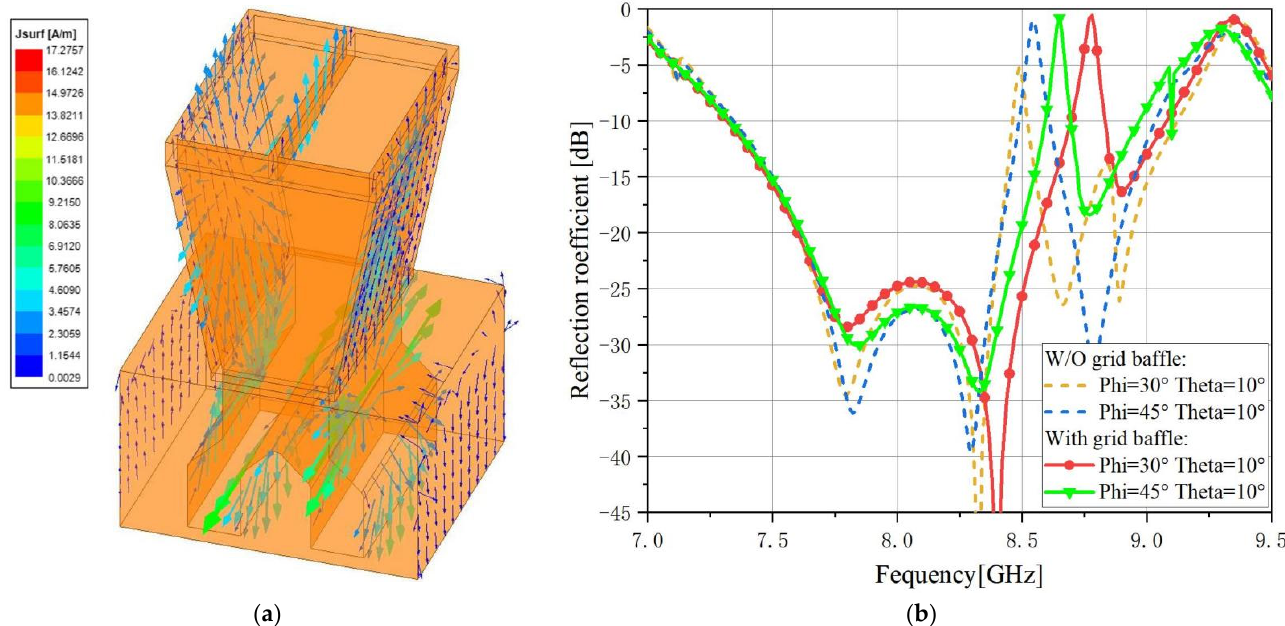
Figure 4. ( a ) The surface current distribution at the horn aperture with the grid baffle added. ( b ) The active reflection coefficients before and after adding the grid baffle.